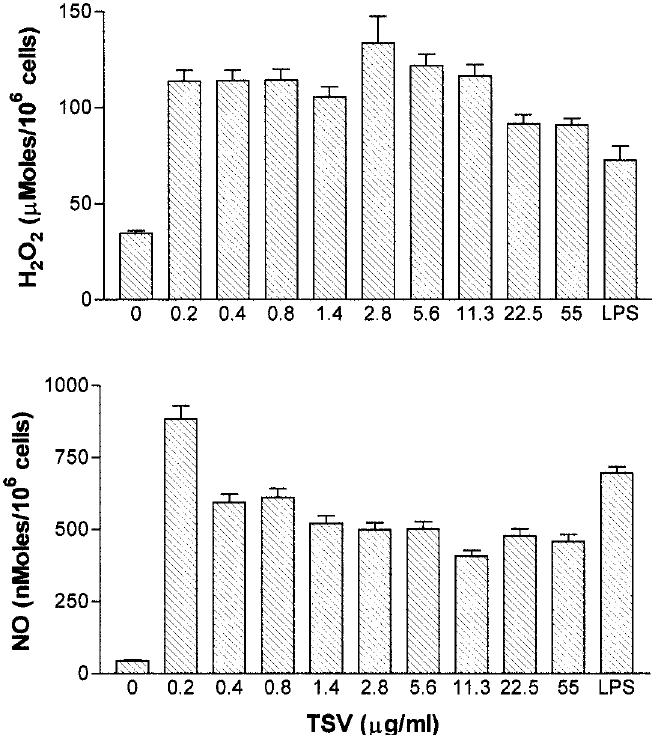
FIG. 6. H 2 O 2 and NO production. Peritoneal macrophages were obtained and stimulated in vitro as described in Fig. 1. H 2 O 2 levels and NO levels were determined 72h post-stimulation. Each point represents the mean ± standard deviation value of samples from five experiments in different groups of five mice.